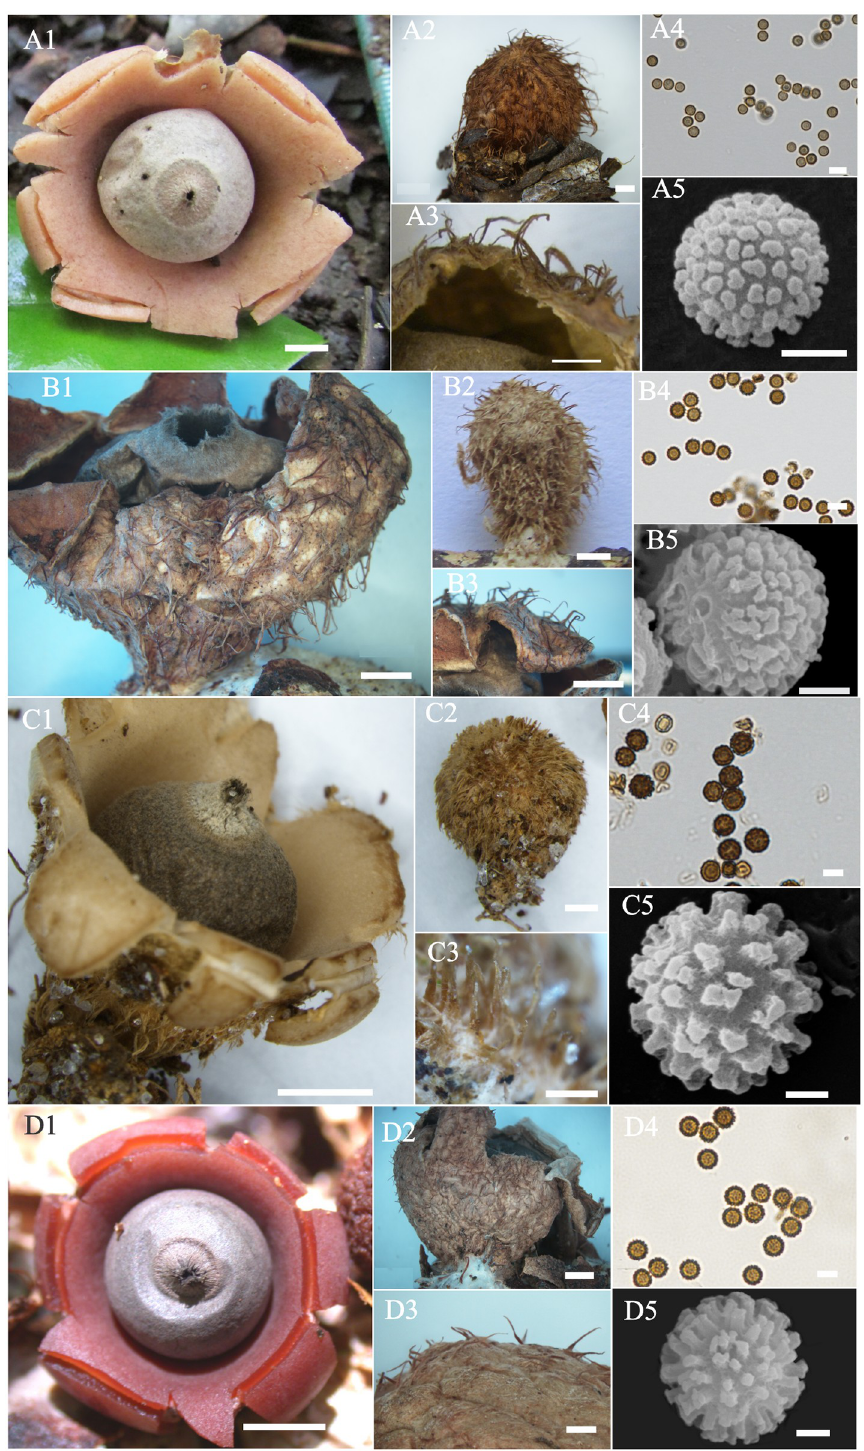
Fig 5. Geastrum hirsutum and allies. (A) Geastrum brunneocapillatum sp. nov. (B) Geastrum hirsutum . (C) Geastrum pusillipilosum . (D) Geastrum rubellum sp. nov. A1, B1, C1, D1 Expanded basidiomata. A2, B2, C2, D2 Unexpanded Basidiomata. A3, B3, C3, D3 Exoperidium detail. A4, B4, C4, D4 Basidiospores under LM. A5, B5, C5, D5 basidiospores under SEM. A1 bar = 2 mm; A2, A3, C2, bar = 1 mm; B1, B2, B3, C1, D2 bar = 2 mm; C3 bar = 0.1 mm; D1 bar = 4 mm; A4, B4, C4, D4 bar = 5 μ m; A5, B5, C5, D5 bar = 1 μ